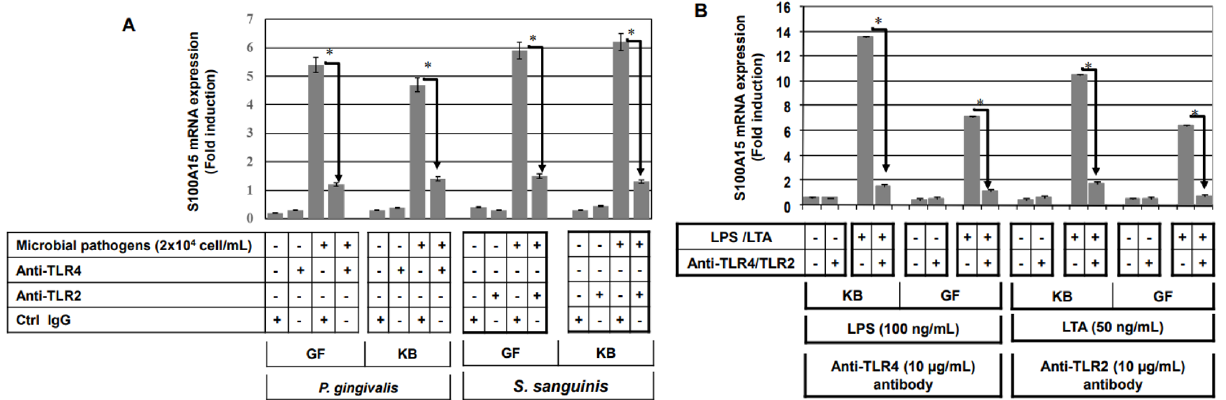
Figure 2. Inhibition of induced expression of S100A15 by neutralization of toll-like receptors. ( A ) GF and KB cells were pre-treated with anti-TLR2, anti-TLR4, or control IgG 1 h prior to the stimulation with either heat-inactivated P. gingivalis or heat-inactivated S. sanguinis for 48 h. Total RNA was extracted from treated and control cells and subsequently subjected to qRT-PCR analysis to assess the relative transcription levels of S100A15. ( B ) GF and KB cells were pre-treated with anti-TLR2, anti-TLR4, or control IgG 1 h prior to stimulation with either LPS (100 ng/mL) or LTA (50 ng/mL) for 48 h. Total RNAs were extracted from treated and control cells and subsequently subjected to qRT-PCR analysis to assess the relative transcription levels of S100A15. Densitometric quantification of S100A15 mRNA over actin mRNA transcript. The data were normalized to the level of treated and untreated control cells in each sample. Each bar represents the mean ± SD of three independent experiments performed in duplicate, * p <